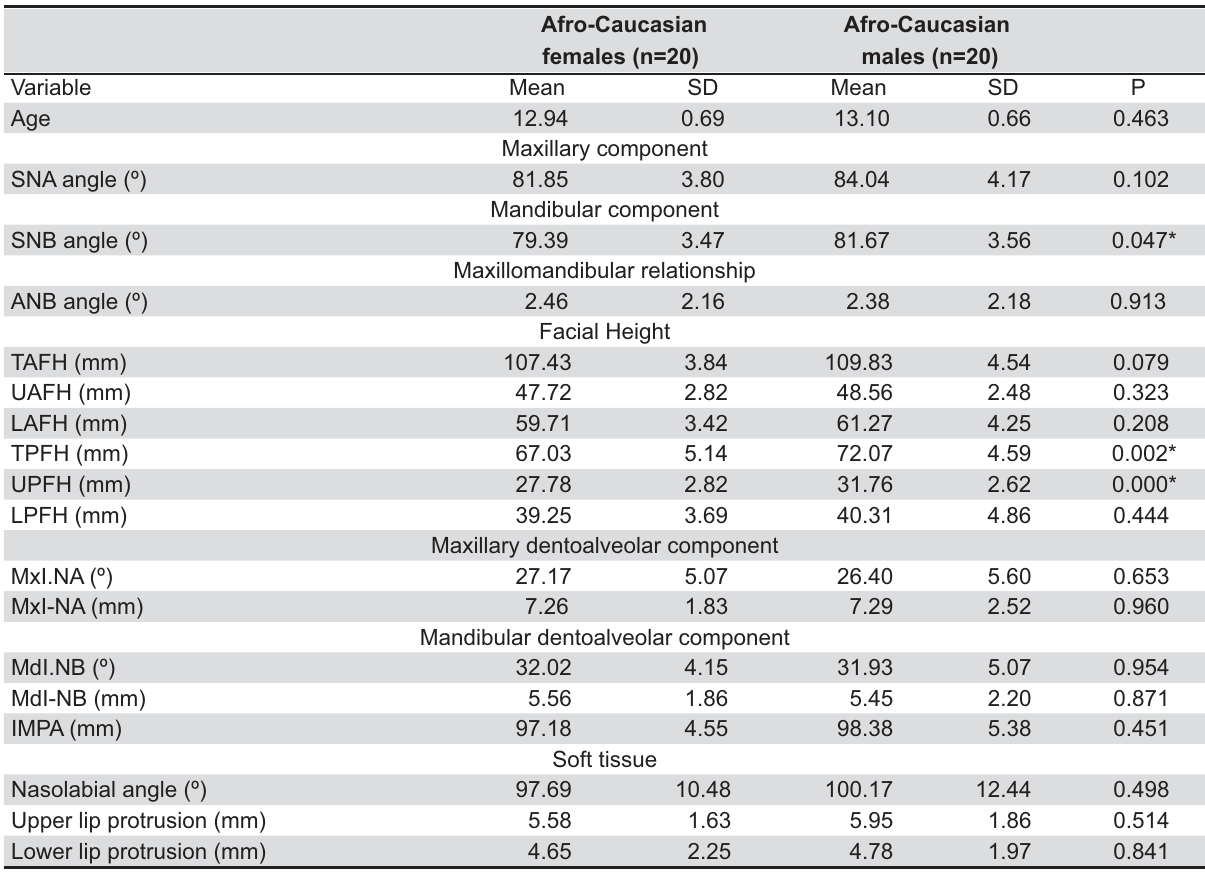
Table 3- Means and standard deviations (SD) of age and skeletal, dentoalveolar, and soft-tissue variables for Afro-Caucasian subjects and results of t